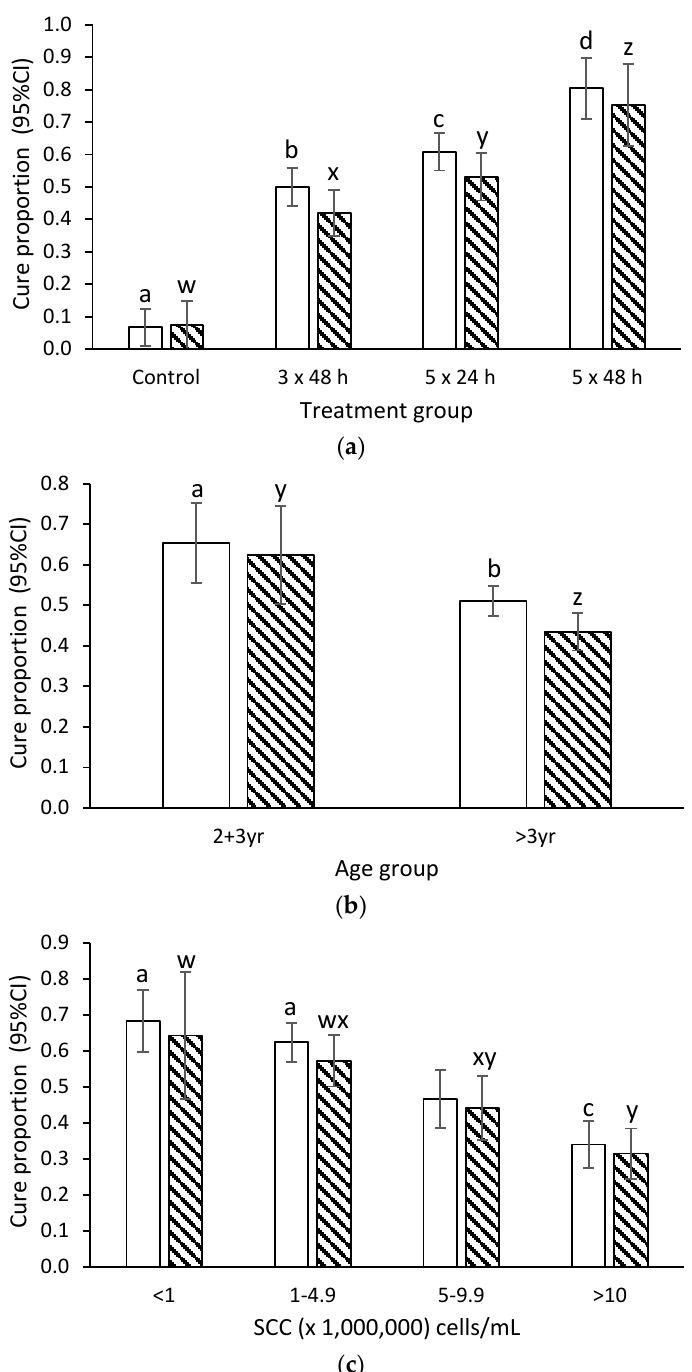
Figure 1. Estimated mean cure proportion (with 95% confidence limits) for treatment of subclinical mastitis with intramammary cloxacillin by ( a ) treatment group, ( b ) age, and ( c ) quarter-level SCC prior to treatment for any pathogen (open bars) or for major pathogens (cross hatched bars). Within pathogen type, columns with differing superscripts differ at p < 0.05.